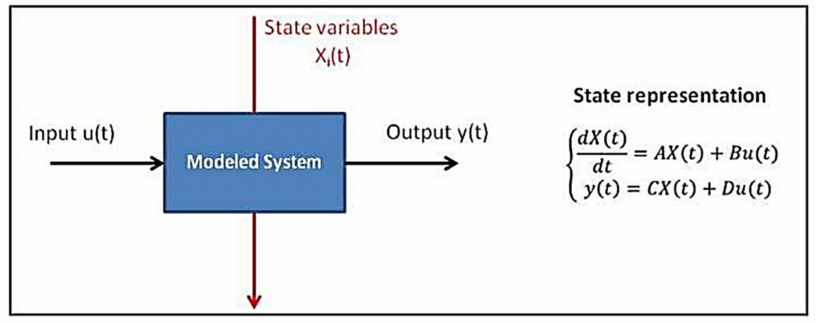
Figure 8. State-space